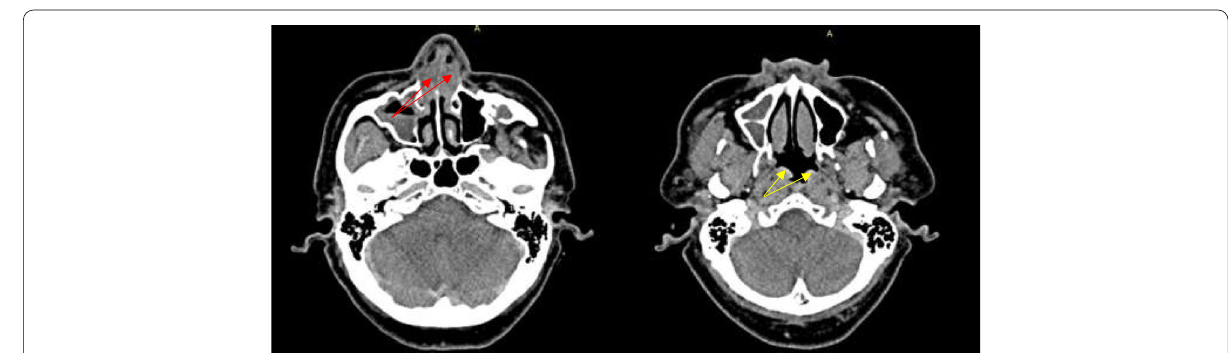
Fig. 3 Axial contrast-enhanced CT images showing enhancing masses at bilateral anterior nasal cavities (red arrows) and nasopharynx (yellow